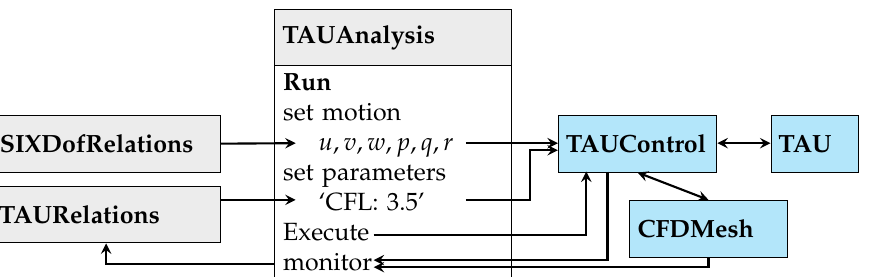
Figure 2. Interaction of the components. The TAUAnalysis of ultrafloads updates the TAU solver via the TAUControl class, which manages the communication and datastreams. The necessary information and parameters are received from the corresponding relations